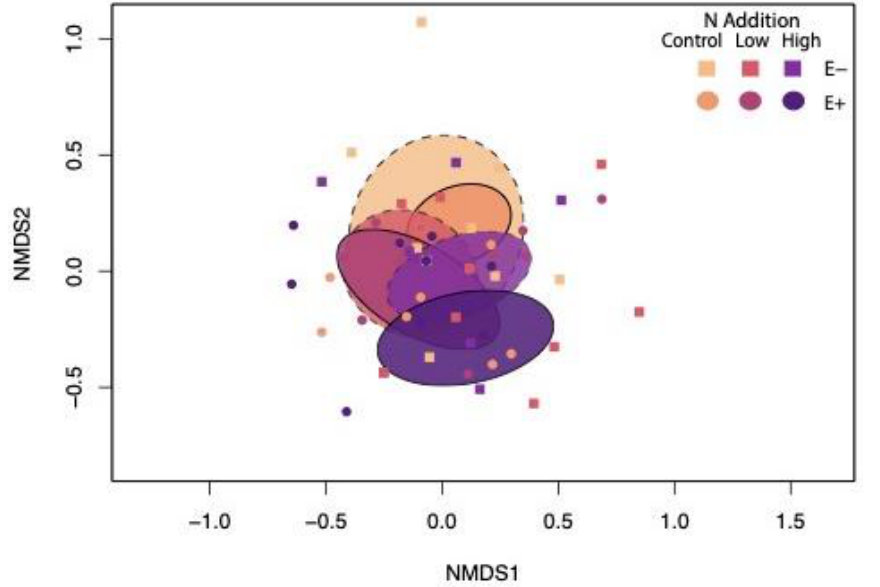
Figure 2. Nonmetric multidimensional scaling plot displaying differences in root endophyte com- munity composition among Epichloë and N addition treatments. 2D stress = 0.2. Ellipses represent standard deviation of point scores for each treatment interaction. Dashed lines represent E − plots.